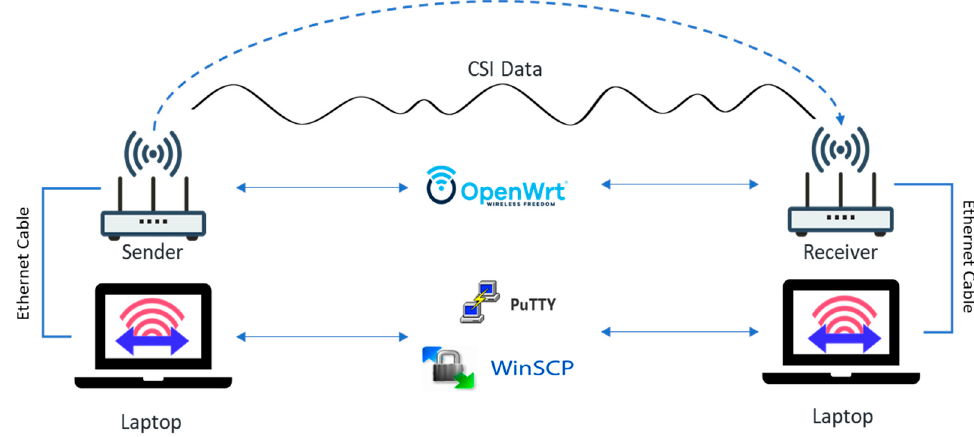
Figure 3. Data collection